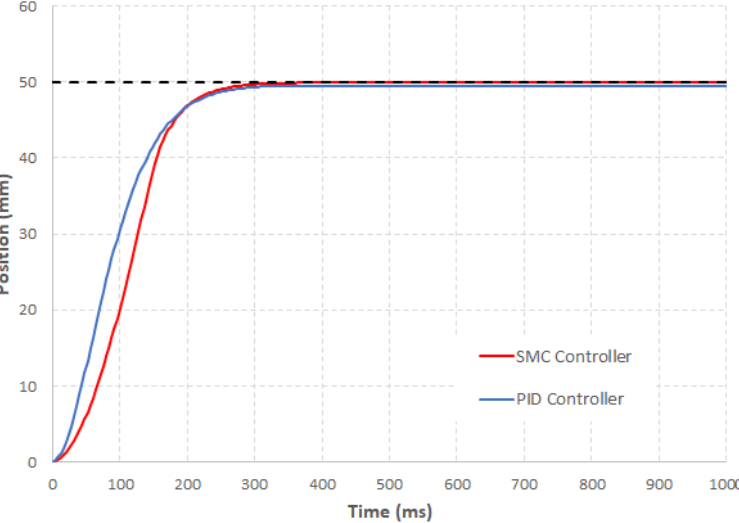
Figure 4. Control performances of the SMC and PID controllers in step tracking.